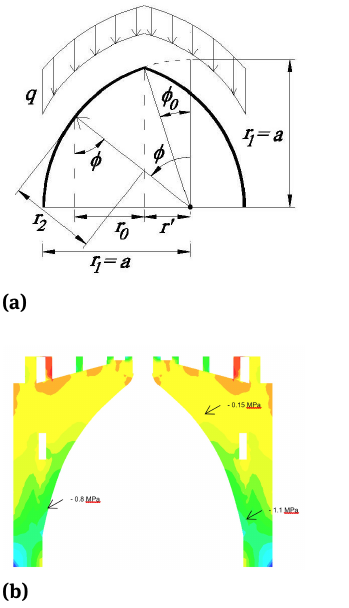
Figure 9: Test case 5: (a)-left geometrical representation of the dome using Flugge’s theory for analytical solution and finite el- ement modelling. (b)-rightValues derived from PPRSI results in perfect agreement with values derived from 3D